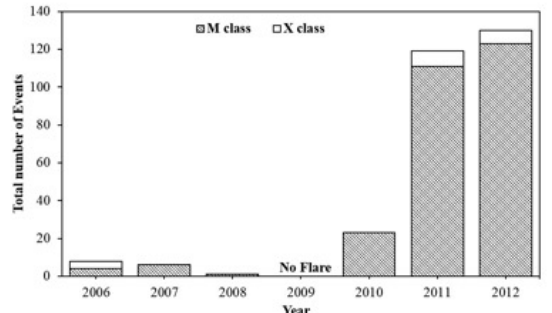
Figure 5. Variation of M and X classes of solar flares between the years 2006 and